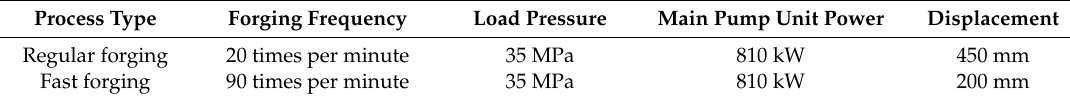
Table 1. Parameters of the upsetting